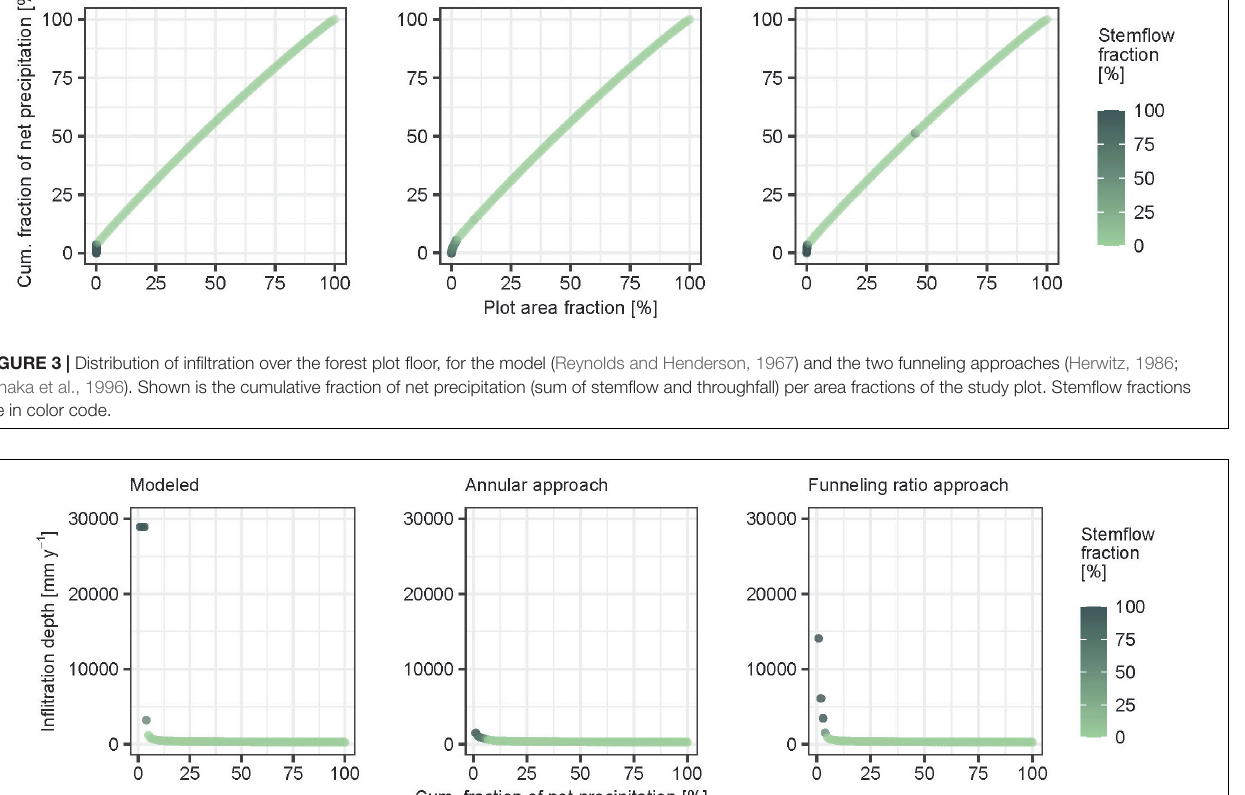
FIGURE 4 | Transfer of net precipitation into infiltration intensity, for the model (Reynolds and Henderson, 1967) and the two funneling approaches (Herwitz, 1986; Tanaka et al., 1996). Shown is the fraction of net precipitation (sum of stemflow and throughfall) contributing to a given infiltration depth. For example, in the center panel 1% of the total annual net precipitation over the forest plot concentrates to a location with infiltration depth of more than 1,500 mm per year, while in the left panel 1% contribute to an infiltration depth of 30,000 mm per year. Stemflow fractions are in color code.